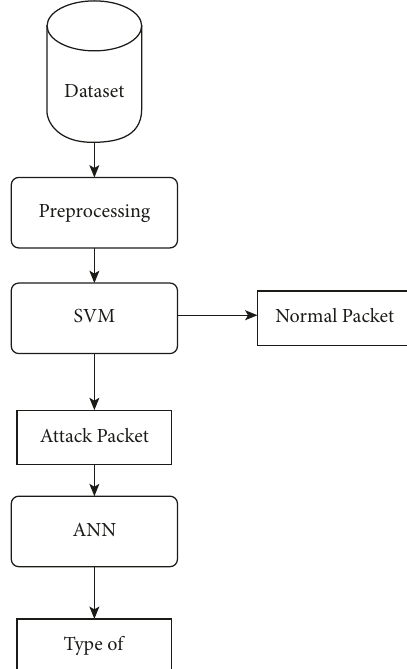
Figure 4: Flowchart of SVM-ANN